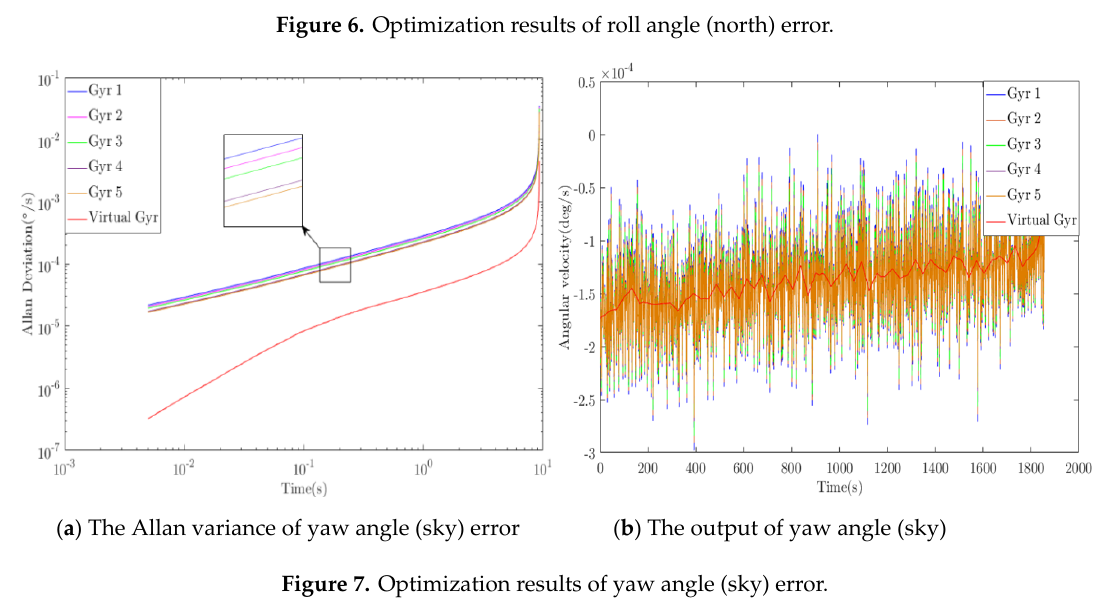
Figure 6. Optimization results of roll angle (north) error. Table 2. Optimization results of roll angle (north) error.